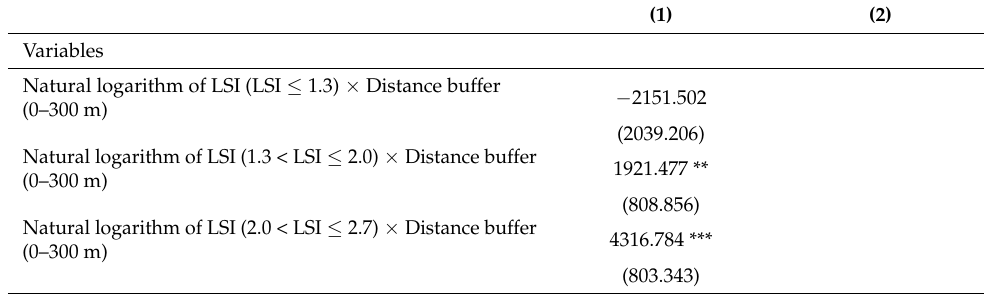
Table 4. Interaction term between distance buffers’ dummy, green spaces’ size dummy and LSI dummy.